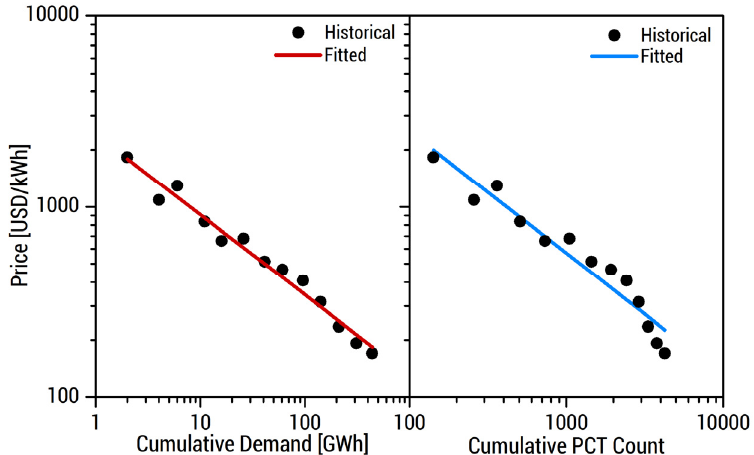
Figure 3. Learning rates using the single-factor learning curve model for Li-ion NMC battery storage. The figure shows learning by using ( left ) and learning by innovation ( right ).